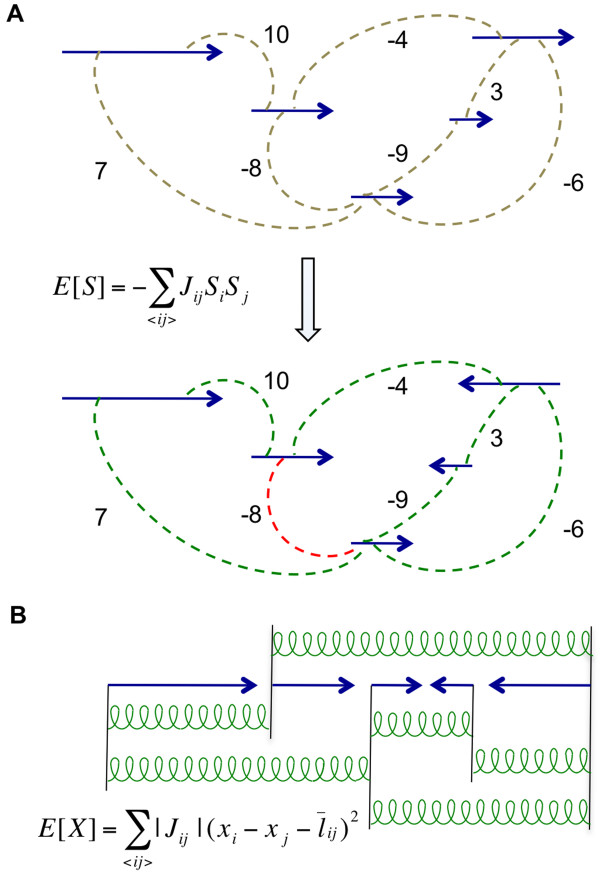
Modeling constraints on the contig connectivity graph. (A) For two contigs i and j connected through mate pairs, the quantity Jij encodes the information about relative orientation (sign of Jij) and number of mate pairs connecting those contigs (absolute value of Jij). Minimizing the energy produces an orientation assignment that satisfies as many constraints as possible. The constraints that are not satisfied in the optimal configuration (shown in red) are ignored in the next part. (B) To determine the relative position of contigs, we model the collection of mate pairs connecting contigs i and j as a spring attached to the start points of those contigs. The relaxed length of this spring, , is equal to the average suggested distance between the start points of those contigs given by mate pair constraints.